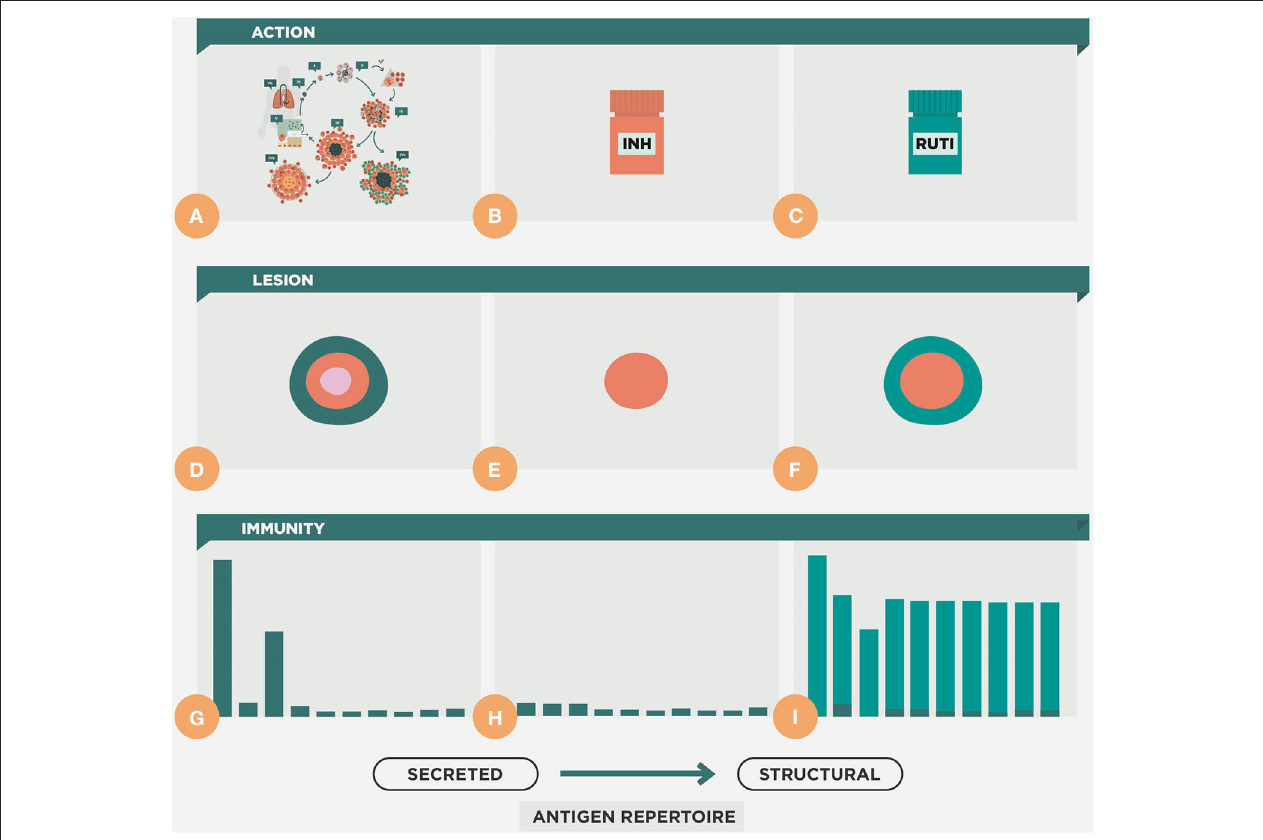
FIGURE 9 | Therapeutic approach of the RUTI vaccine. This figure shows the natural evolution of the infection, with constant cycles of reinfection (A,D,G) . During chemotherapy there is a reduction of the lesion and the cellular immune response (B,E,H) . Upon vaccination with RUTI (C,F,I) there is an increase in the immune response that includes a wider repertoire, compared to that obtained with the usual reinfection process, which is more focused on the secreted antigens, as shown in Figure 4